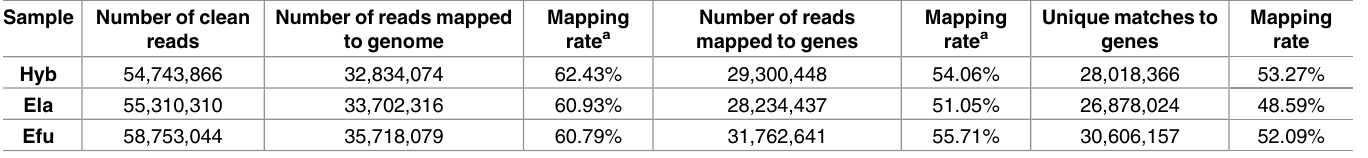
Table 1. Statistics of transcriptome data generated from the hybrid F1 and its parents. Sample Number of clean